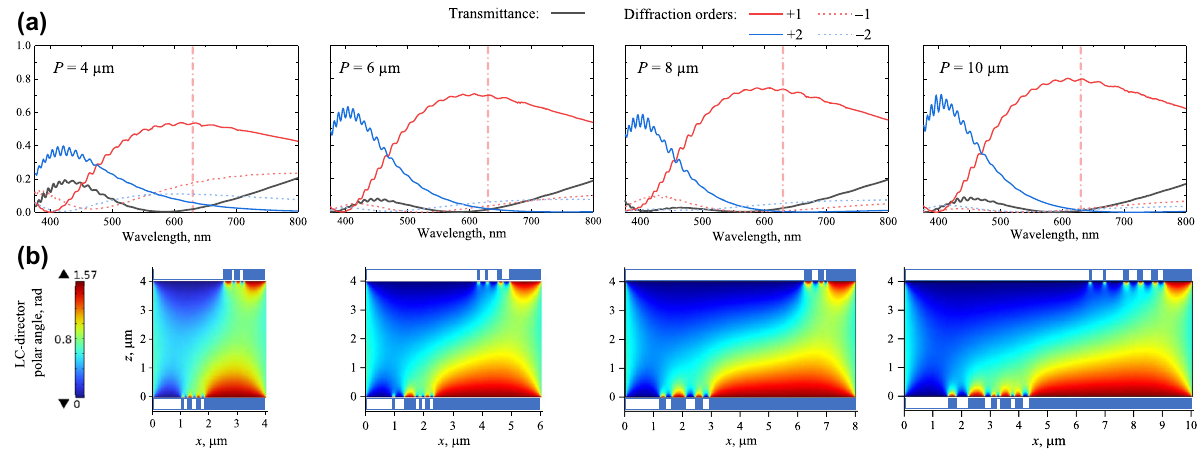
Figure 2: Double-sided LC-metasurfaces numerically optimized for maximum efficient anomalous refraction of red light into + 1 diffraction order.